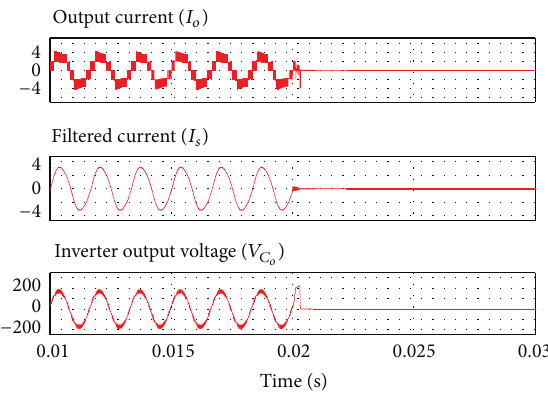
Figure 10: Steady-state operation of multilevel output current and inductors current. Top to bottom: multilevel output current ( 𝐼 𝑜 , 2A/div), inductor current ( 𝐼 𝐿1 , 1A/div).